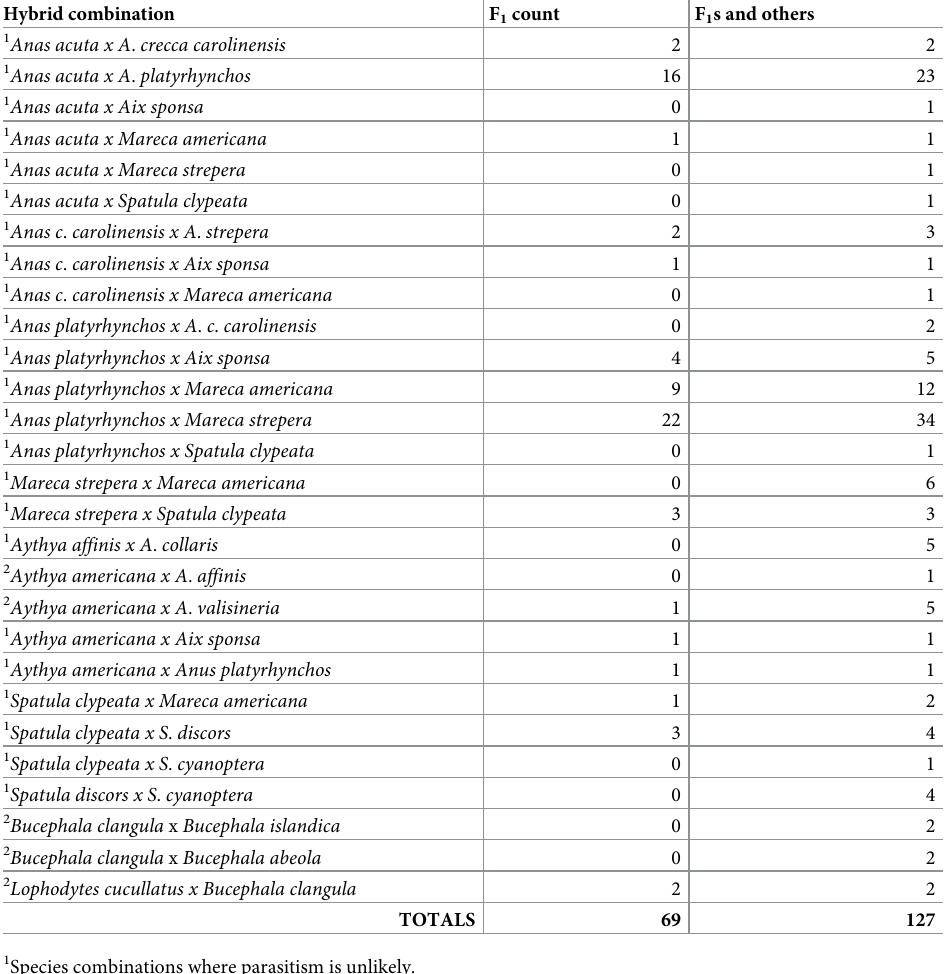
Table 3. Counts of hybrids used to assess the brood parasitism hypothesis and to compute expected frequencies for Fig 1. “F 1 count” lists genetically identified F 1 s with known sires. “F 1 s and others” gives the hybrids used in the computation of expected frequencies. The additional hybrids in this column were identified morphologically but lacked full genetic data and will include a few backcrosses. Mareca americana x M . penelope hybrids were excluded from these analyses because most were target